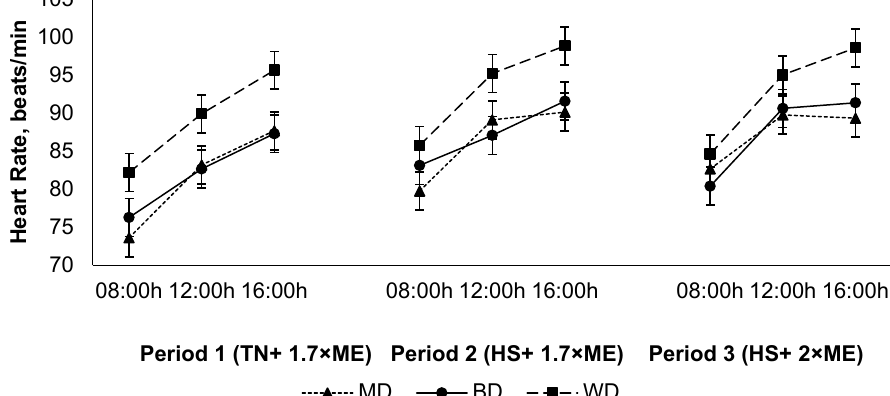
Figure 4. Relationship between heart rate, time of observation, and experimental period in sheep fed on different diets. The standard error of the difference for the interaction between period and dietary treatments and time is displayed on the graph. The p -values for the effects of diet, period, time, diet * period, diet * time, period * time, and diet * period * time were p ≤ 0.01, p < 0.001, p < 0.001, p = 0.60, p = 0.10, p = 0.15, and p = 0.28. The rectal temperature increased in response to HS (P1 vs. P2), with a further small